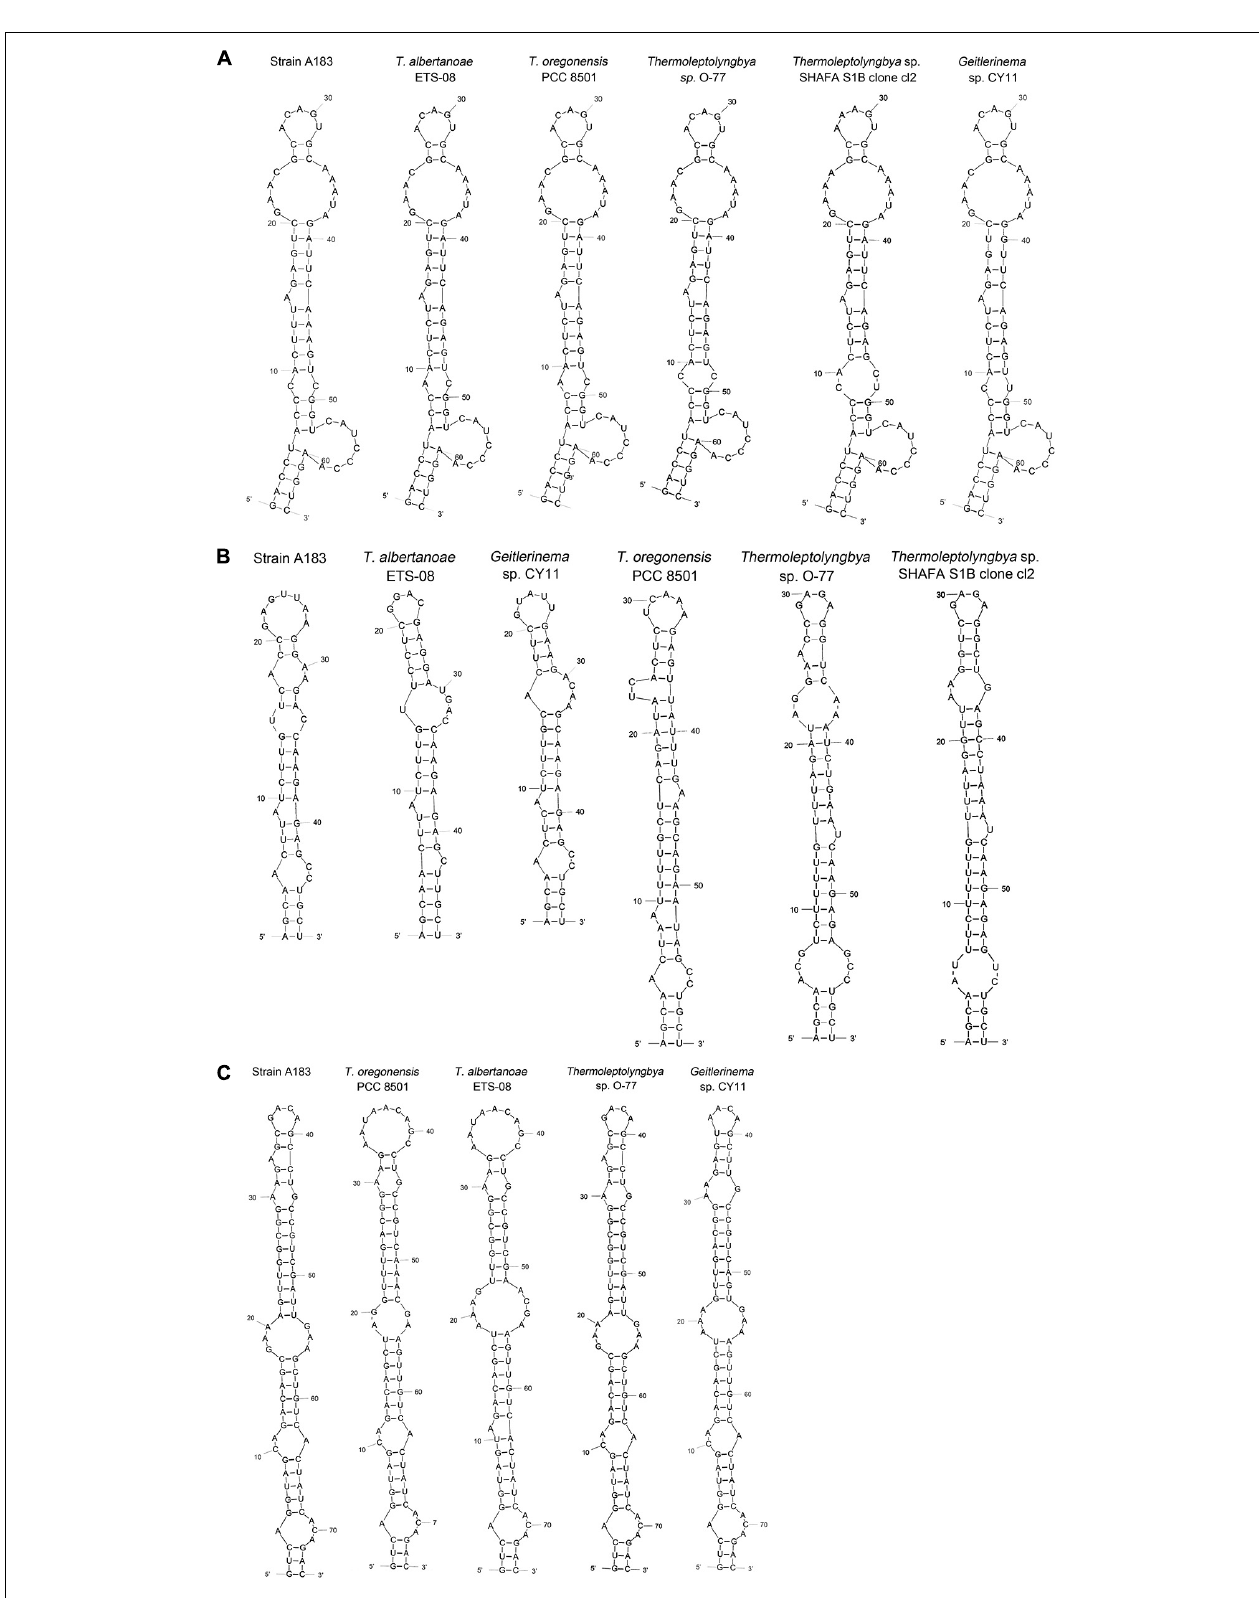
Frontiers in Microbiology |